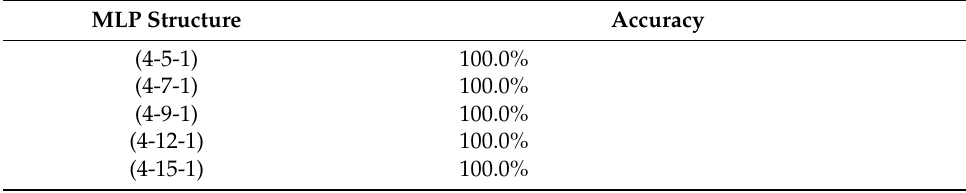
Figure 14. The impact of the MLP structure on the MLP classifier accuracy.